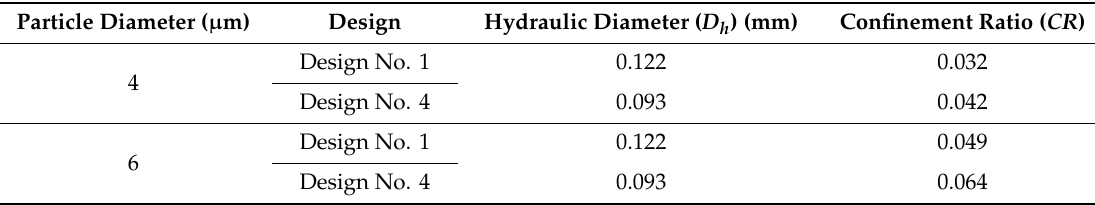
Table 1. Summary of confinement ratio for 4 µ m and 6 µ m particles in varying hydraulic